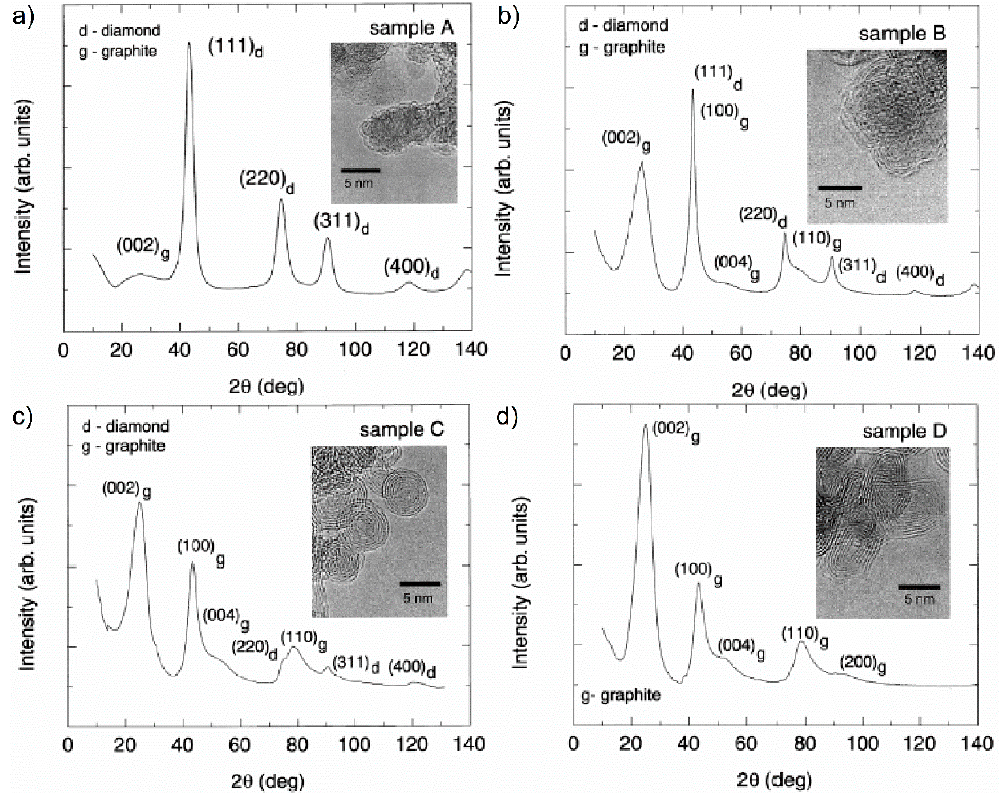
Figure 45. The diffraction intensities together with the TEM images for ( a ) pristine diamond nanoparticles, ( b ) the nanoparticles after heat-treatment at 1400 °C, ( c ) at 1700 °C, and ( d ) at 2000 °C. Reproduced with permission from Tomita et al. [148]. Copyright AIP Publishing, 2002.